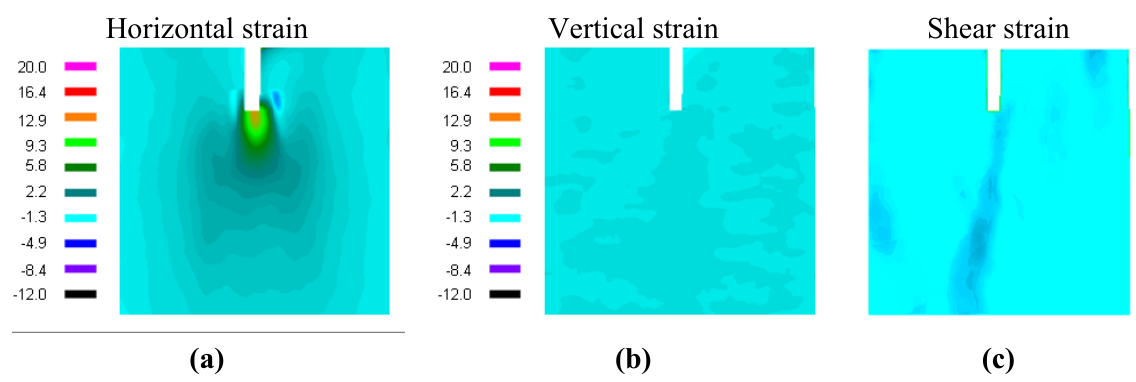
(µm/mm); ( b ) measured xx